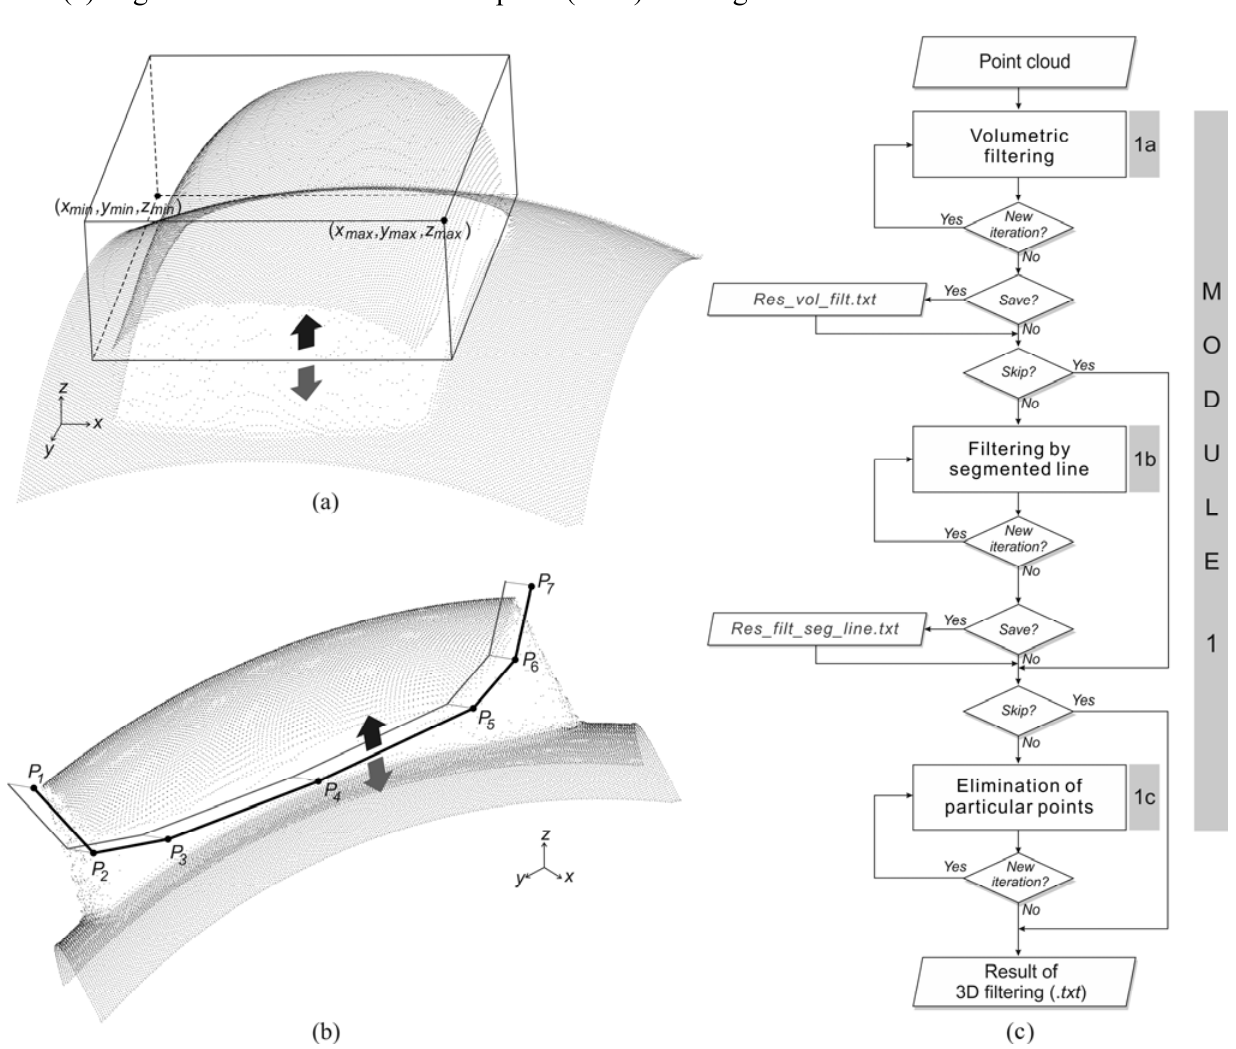
Figure 2. ( a ) Principle of the volumetric filter. ( b ) Principle of the segmented line filter. ( c ) Algorithm of the module for 3D point (error)